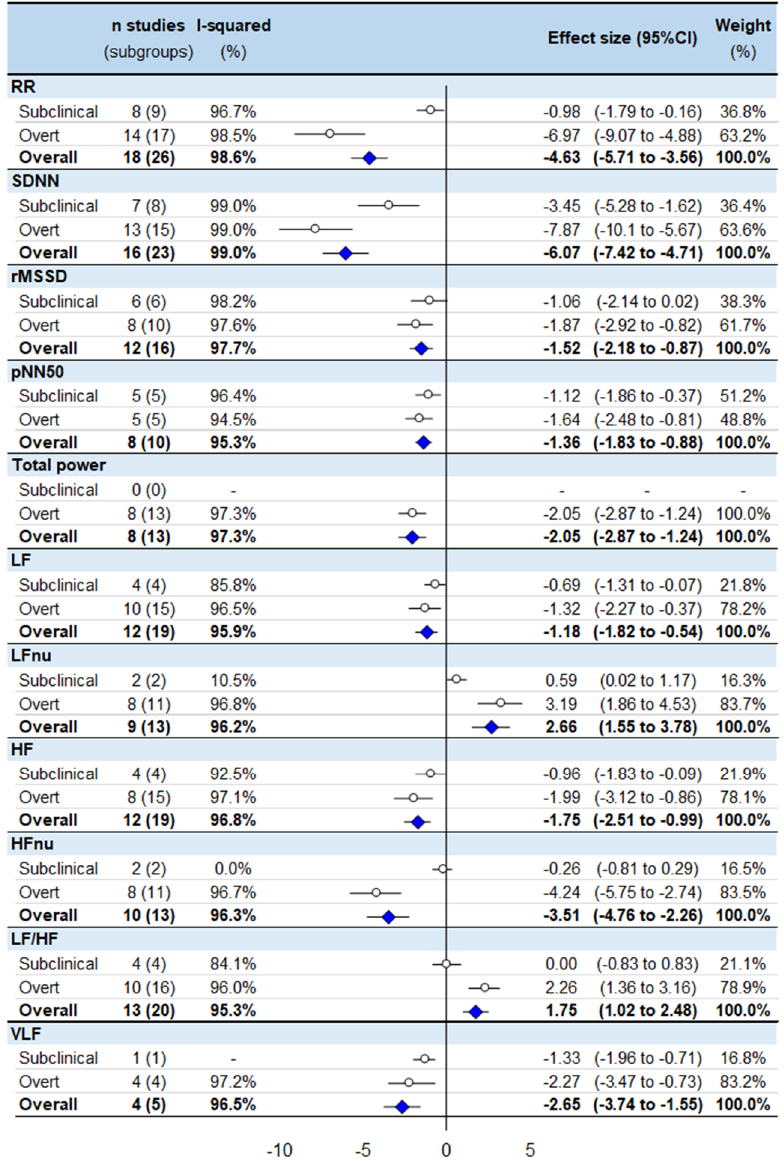
Figure 2. Meta-analysis of HRV parameters of untreated hyperthyroid patients compared with controls. RR: RR intervals (or normal-to-normal intervals—NNs), SDNN: standard deviation of RR intervals, pNN50: percentage of adjacent NN intervals differing by more than 50 ms, RMSSD: the square root of the mean squared difference of successive RR intervals, LF: low frequency, LFnu: low frequency-normalized units, HF: high frequency, HFnu: high frequency-normalized units, LF/HF ratio: low frequency/high frequency ratio, VLF: very low frequency.